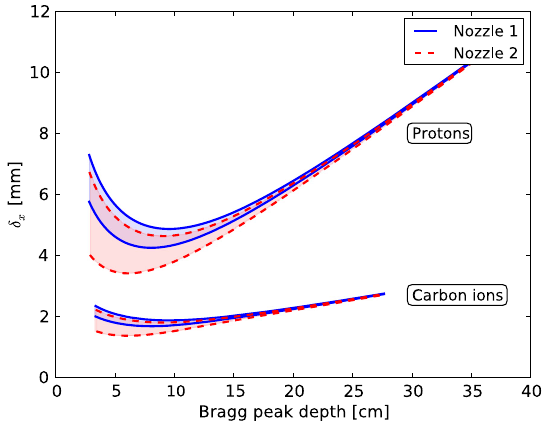
FIG. 13. Thin range shifter: increased scattering and beam growth through nozzle. Thick range shifter: less scattering in nozzle, but larger beam divergence after range